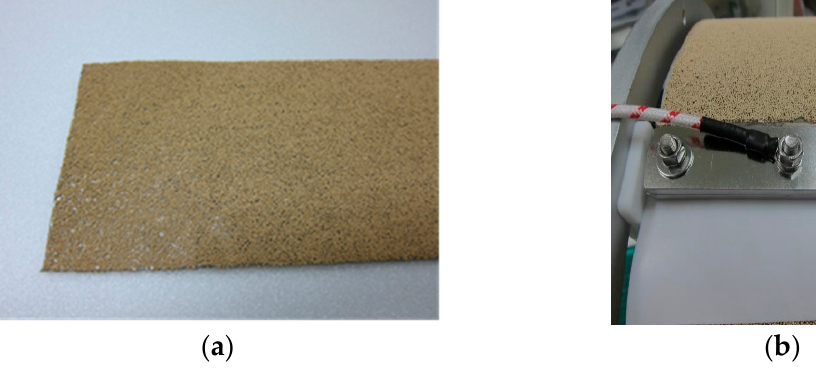
Figure 9. Adsorbent-coated electrothermal metal sheet ( a ) before and ( b ) after curling.